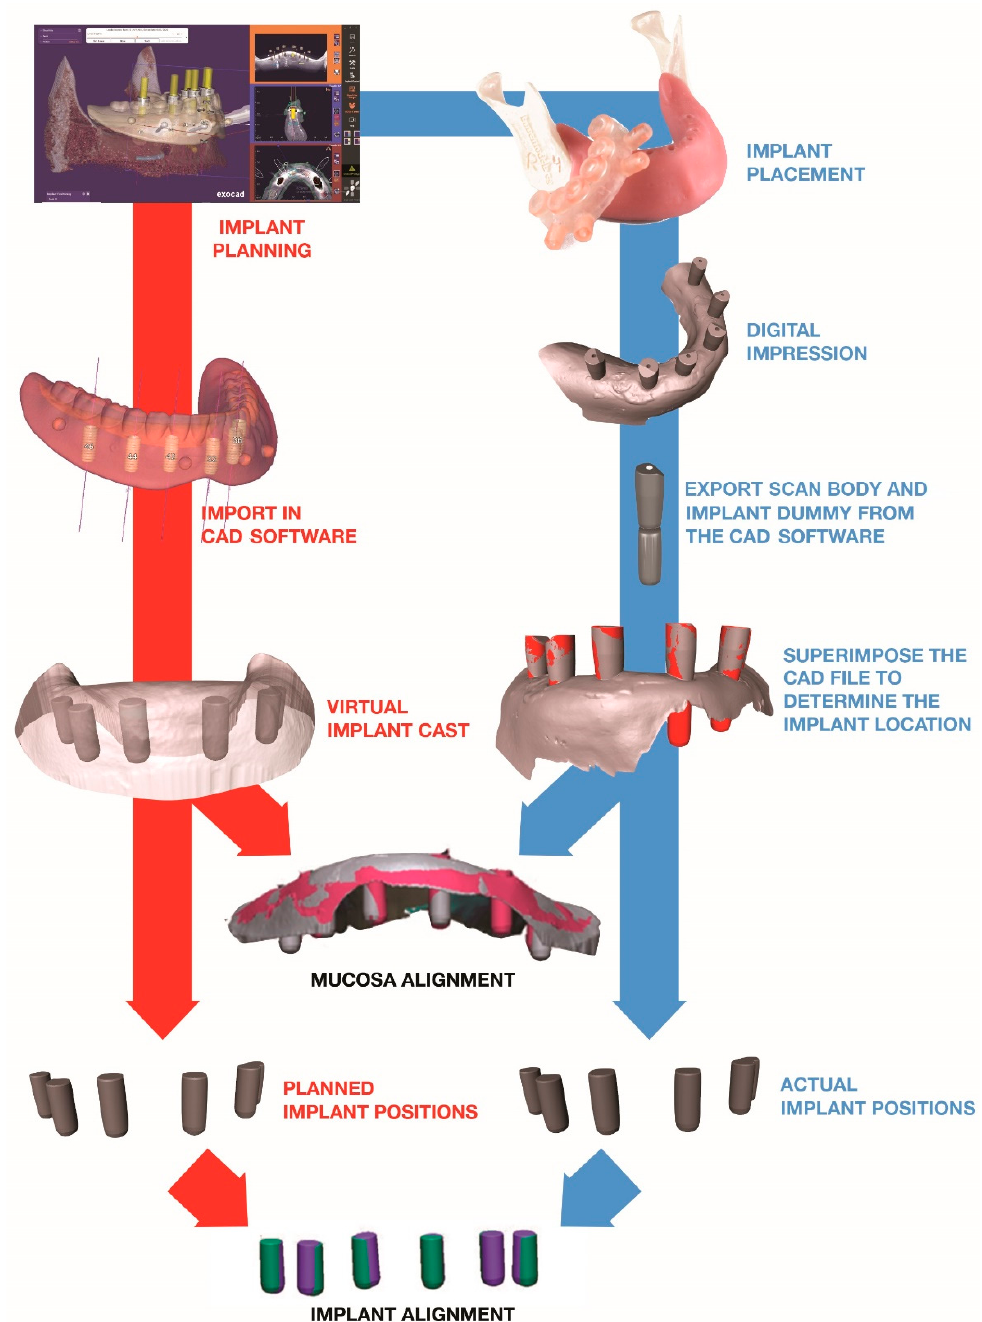
Figure 4. Superimposition of the planned and actual implants, using a best-fit alignment of the implants (A) or of the mucosa (B).